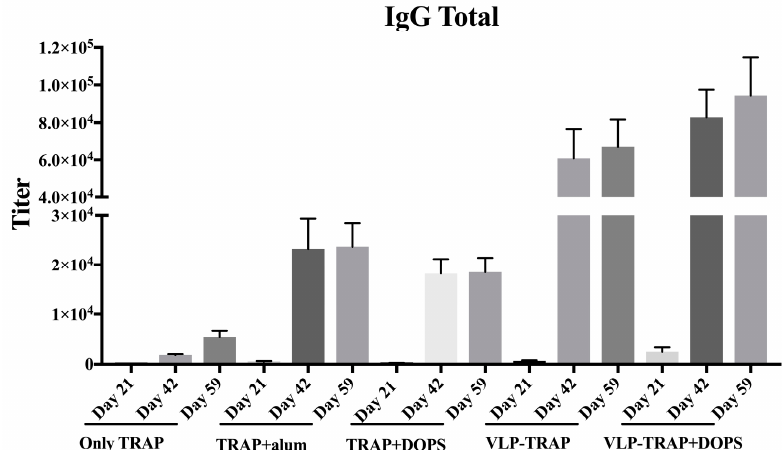
Figure 2. Kinetics of antibody production in BALB/c mice. The figure shows IgG total of all groups of mice bled three weeks after each vaccination, specifically on Days 21, 42, and 59. As seen in the figure, the mice that best responded were those vaccinated with PfTRAP coupled with VLP. Also, when the VLP-PfTRAP was mixed with DOPS adjuvants, it provided an improvement of the antibody response with highly statistical significant ( p = 0.0001) when compared with the control group.